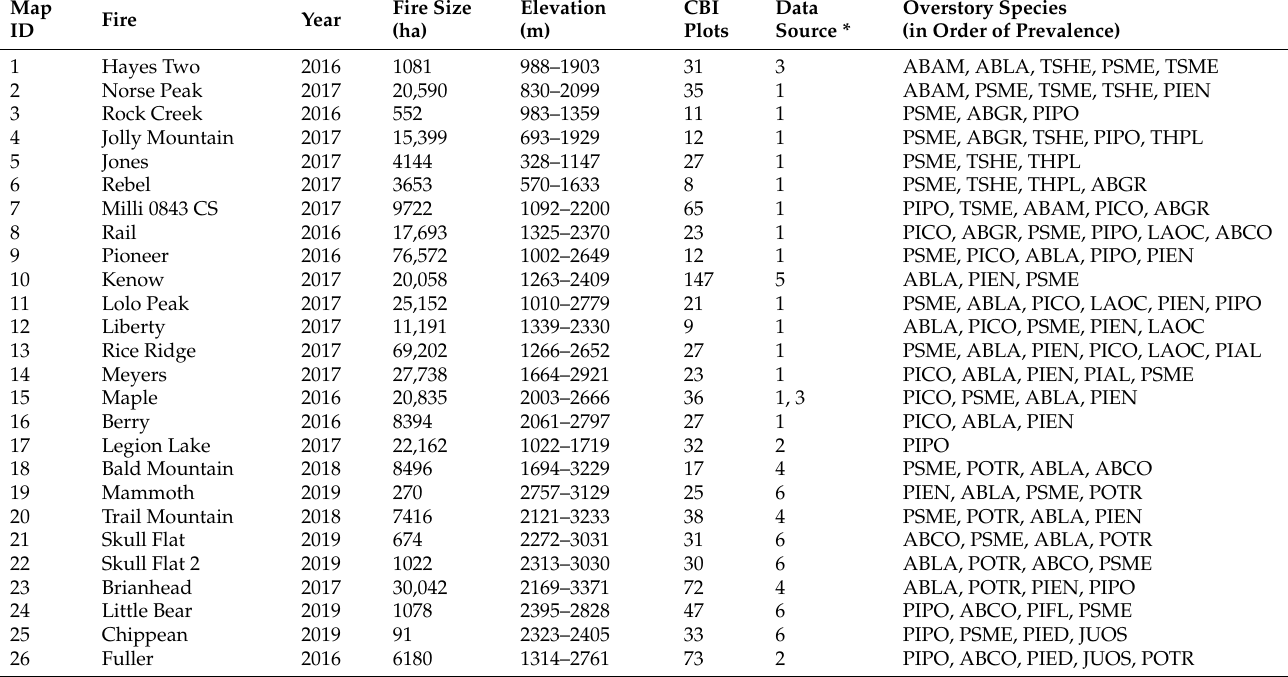
Table 1. Fires analyzed in this study. Overstory species within each fire were estimated from the basal area product of the USDA National Individual Tree Species Atlas [55], which is available within the US. For the Kenow fire, which was located immediately north of the US-Canadian border, we delineated a false perimeter just south of the border in similar terrain in order to extract estimates of overstory species prevalence to maintain dataset consistency. Tree species